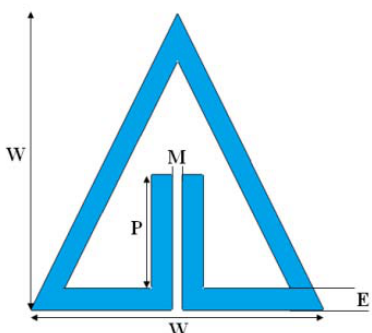
Fig.1 Geometric parameters of the proposed -MTM unit cell with: W = 9.5 mm, E = 0.7 mm, M = 0.3 mm, P = 4.4